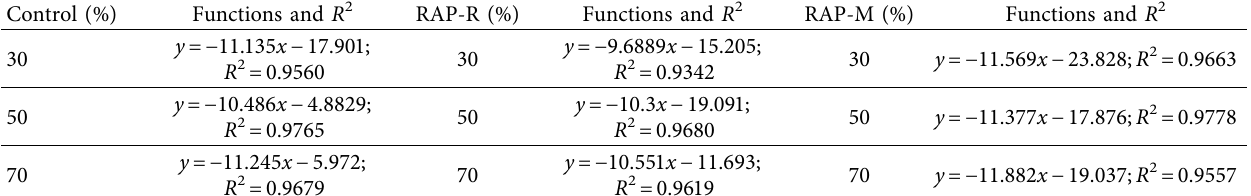
Table 2: Linear regression function and correlation coefficients between relationship of relaxation time λ and temperature.